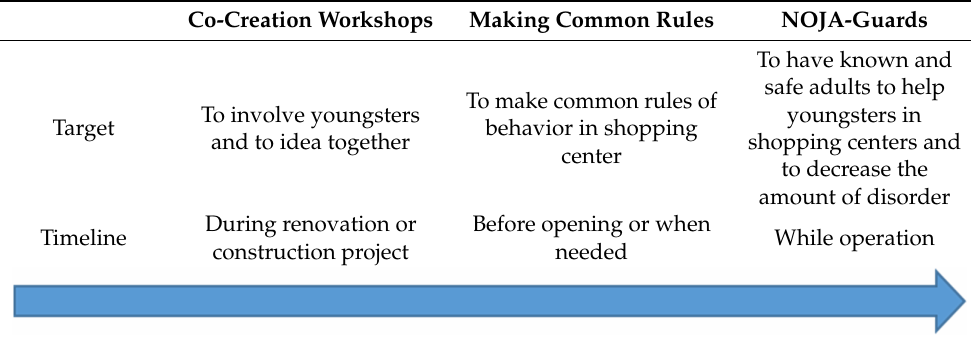
Table 3. Targets and timelines of different youth citizen engagement actions developed and held in Citycon together with Nuorten Palvelu ry.